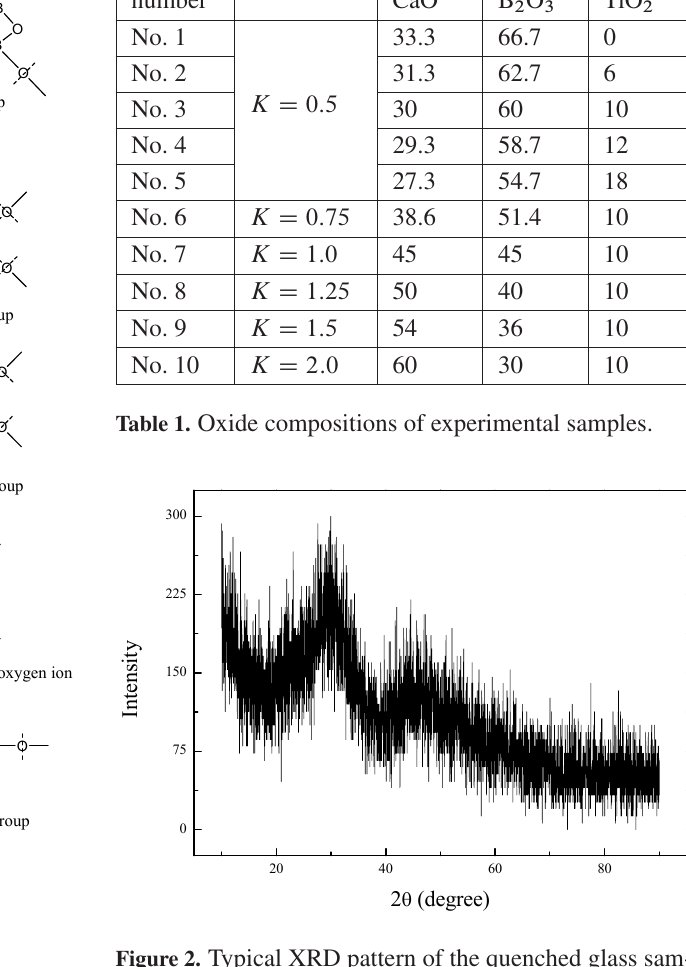
Figure 2. Typical XRD pattern of the quenched glass sam-